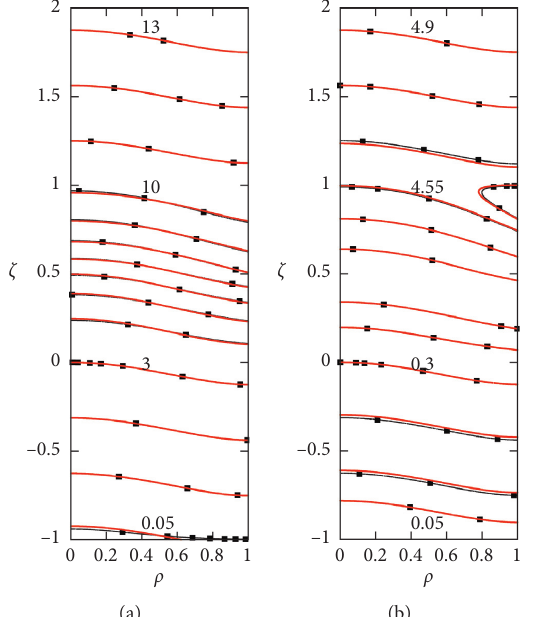
Figure 3: Contour plot of the dimensionless temperature θ ( ρ , ζ ) for the triangular wall heat flux for Pe � 100, α � 0 . 02, and β − � β + � 1. Comparison between numerical results (black lines with dots) and analytical results (continuous red lines). (a) Br � 0 . 1, Kn � 0 . 0; (b) Br � 0 . 01, Kn � 0. Labels indicate some reference temperature